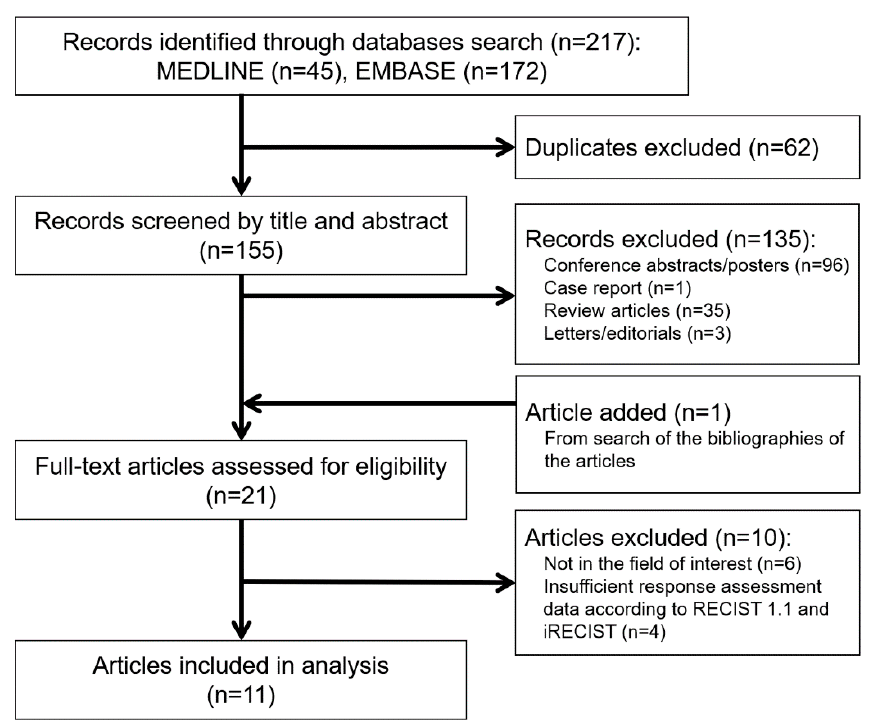
Figure 1. Flow diagram of the study selection process.